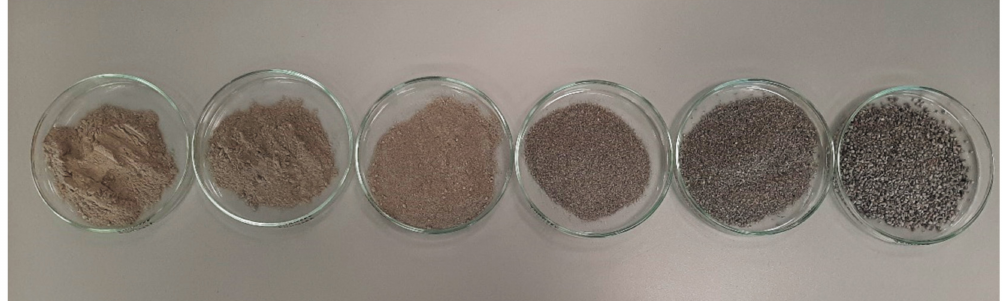
Figure 1. Grain fractions of concrete aggregate, from the smallest from the left: <0.063 mm; 0.063–0.125 mm; 0.125–0.25 mm; 0.25–0.50 mm; 0.5–1.0 mm; 1.0–2.0 mm.